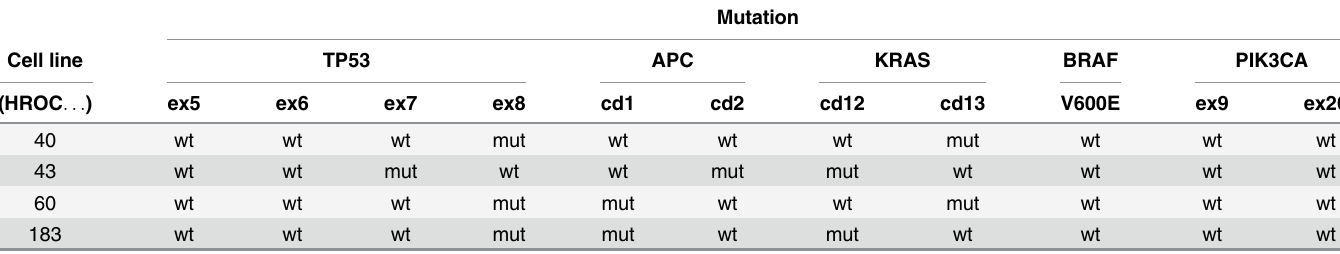
Table 2. Mutational profile of CIMP + cell lines.